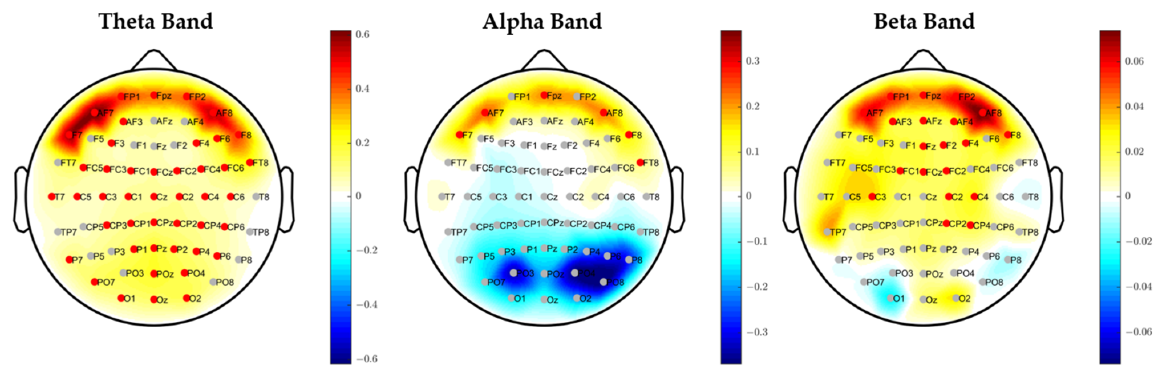
Figure 4. Average over the population of the difference between brain activation in the high condition compared to the low condition in the Theta, Alpha, and Beta band. The color bar represents the difference in power spectral density value (negative values mean that the brain activity in such area is on average higher in low condition compared to high). The electrodes significantly ( p < 0.05 FDR corrected) more active at the High level with respect to the Low level are marked in a red color, those more active at the Low level with respect to the High level are marked in a blue color (none), and the insignificant level is marked in grey.